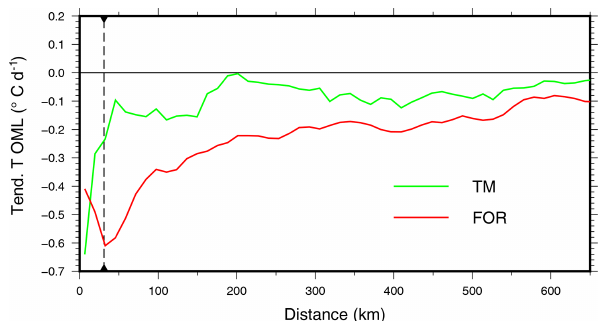
Figure 9. Mean values of the turbulent mixing (green) and surface forcing (red) tendency terms for temperature evolution in the OML at 10:00UTC on 7 November. The values are radially averaged ev- ery 12km from the medicane centre. The vertical dashed line indi- cates the radius of maximum